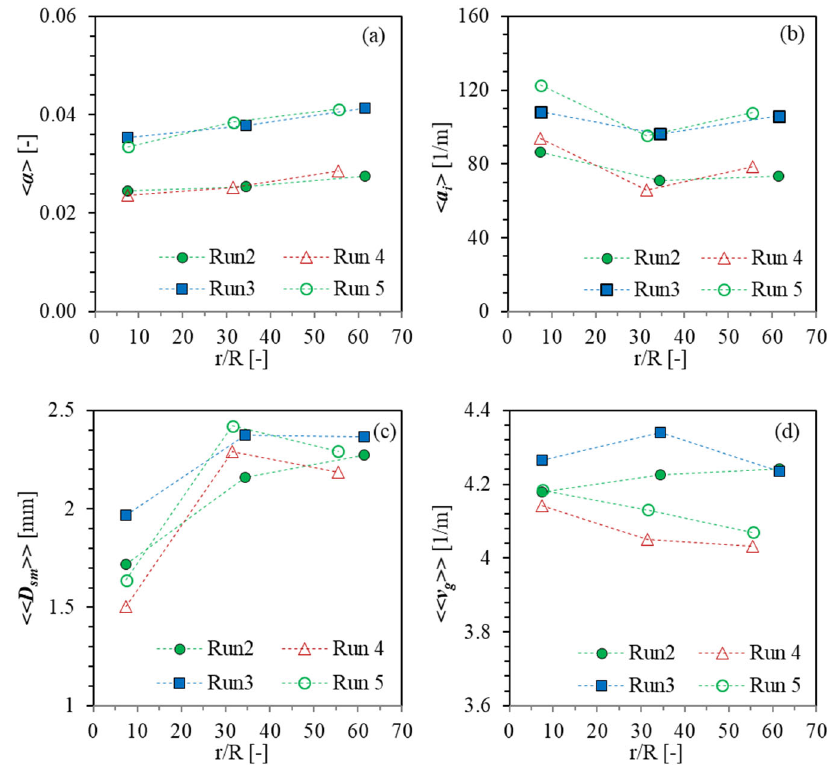
Figure 10. Comparison of area-averaged interfacial parameters between VU and VD two-phase flows, ( a ) void fraction, ( b ) interfacial area concentration, ( c ) bubble Sauter-mean diameter, and ( d ) bubble velocity.